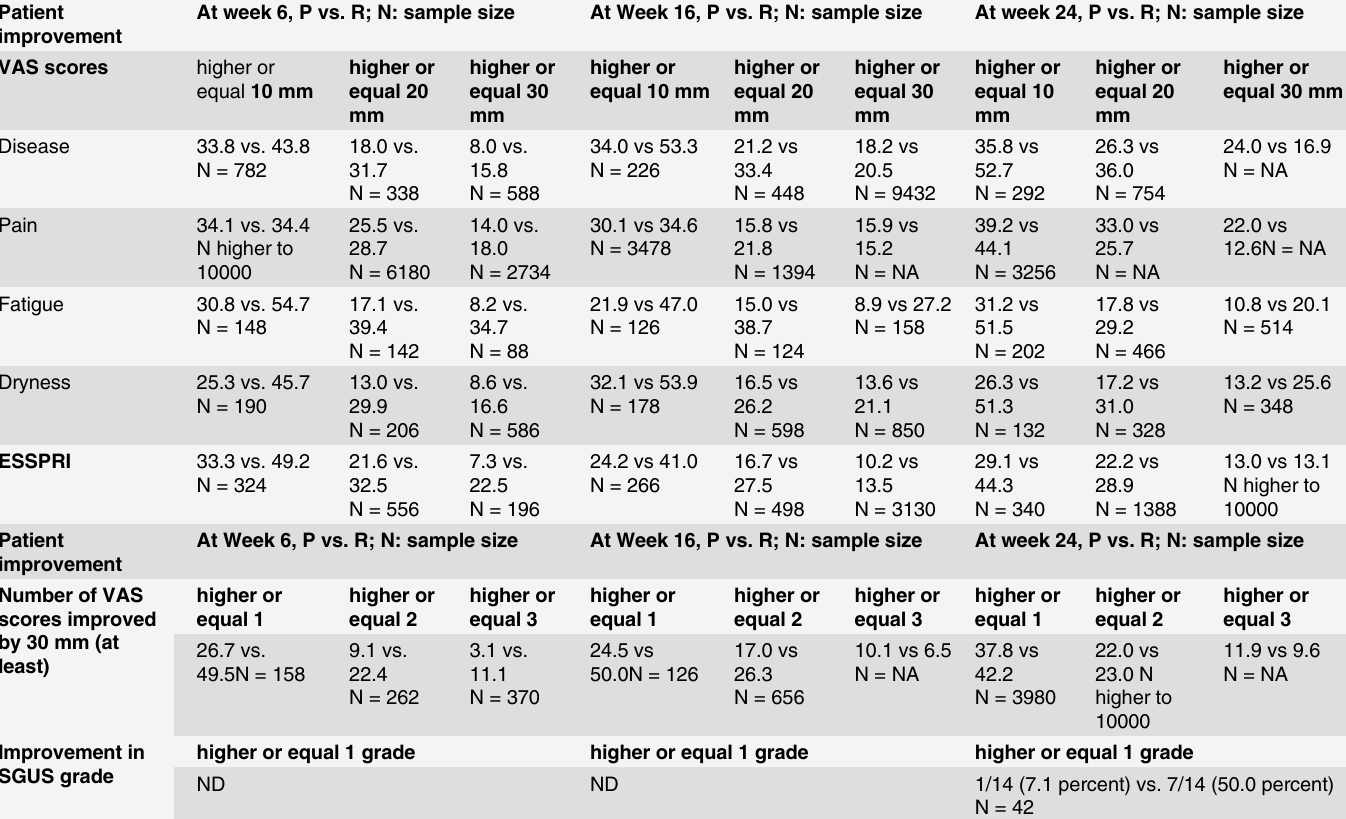
Table 3. Number of patients to include in future randomised controlled trials of rituximab in primary Sjögren ’ s syndrome according to the primary endpoint assessed at weeks 6, 16, and 24. Patient At week 6, P vs. R; N: sample size At Week 16, P vs. R; N: sample size At week 24, P vs. R; N: sample size improvement